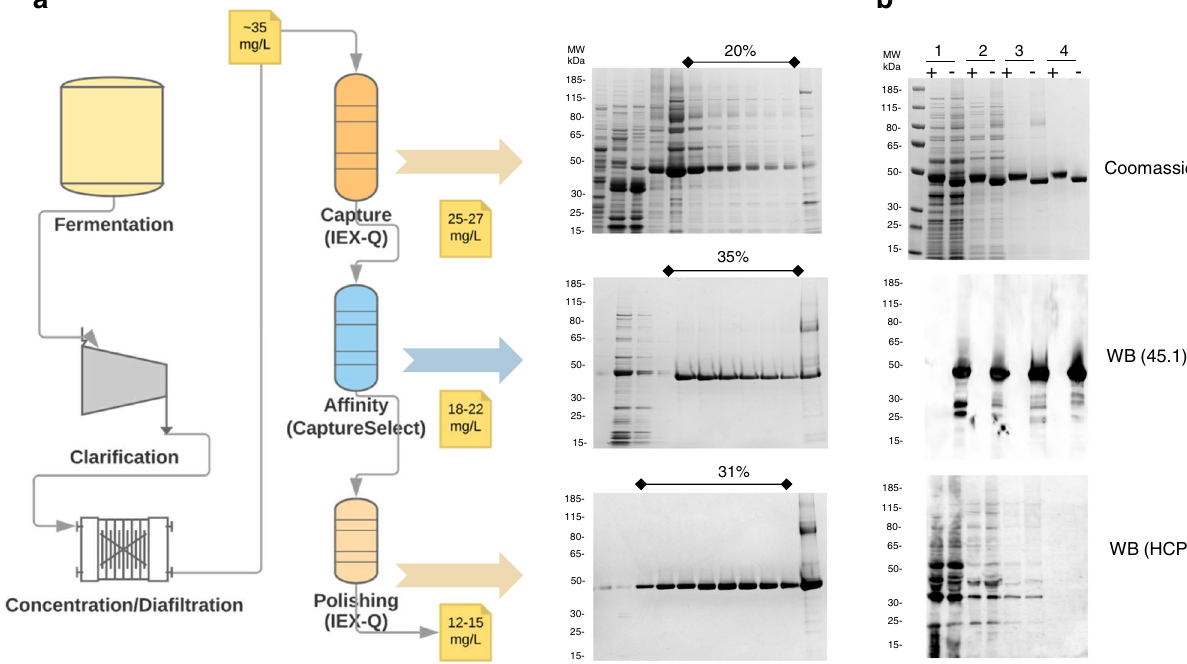
Fig. 3 Production of ProC6C in L. lactis . a Schematic representation of fermentation and three puri fi cation steps of ProC6C protein with associated yields and recovery of puri fi ed protein. Coomassie blue-stained 4 – 12.5% polyacrylamide gel inset with elution fractions (concentration B buffer); upper panel HiPrep Q HP column, middle panel Capture selectXL column, and lower panel HiPrep Q HP. The sample was loaded without a reducing agent. b Analysis of puri fi ed ProC6C by SDS-PAGE; upper panel ; 1 dia fi ltrate, 2 HiPrep Q HP column, 3 Capture selectXL column, 4 HiPrep Q HP column puri fi ed ProC6C. An immune-blot analysis of the same gel shown in the upper panel using mAb45.1 and anti- L. lactis antibodies (detection of HCP) in the middle and lower panels , respectively. Protein was loaded in each lane with ( + ) or without ( − ) DTT (10 mM). The sizes (kDa) of the molecular mass markers are indicated. All blots and gel are derived from the same experiment and processed in